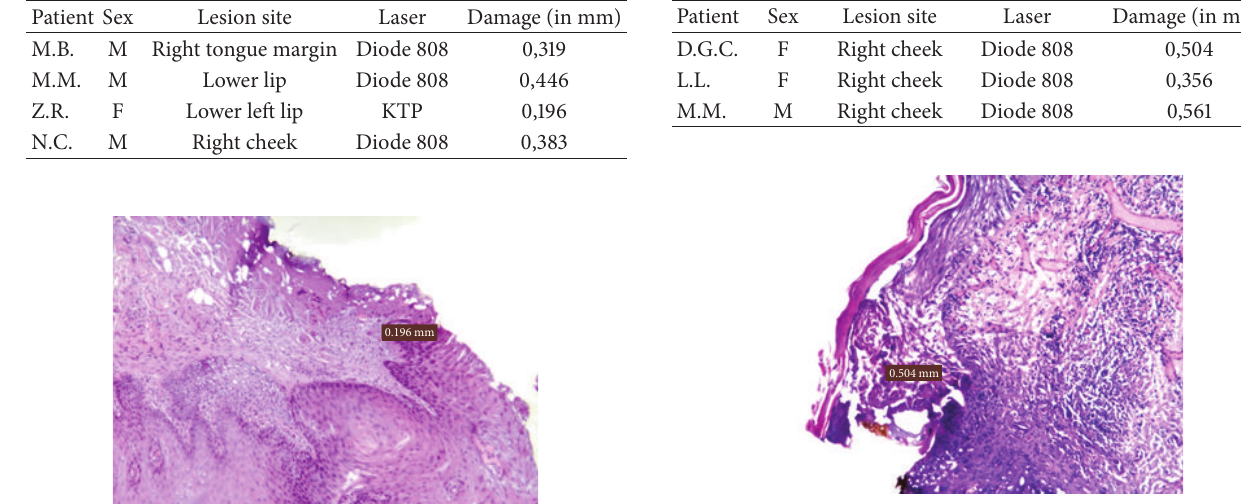
Figure 7: Damage measurement in an oral lichen planus.